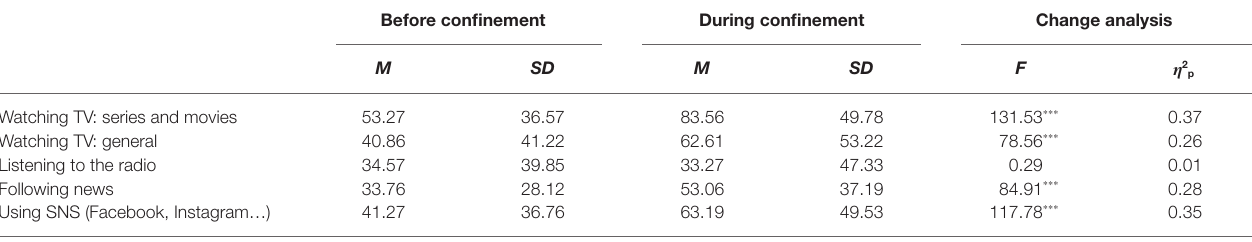
TABLE 3 | Pearson bivariate correlations between habits during confinement and happiness dimensions. General well-being Eudaimonic well-being Hedonic well-being Social well-being Experienced well-being